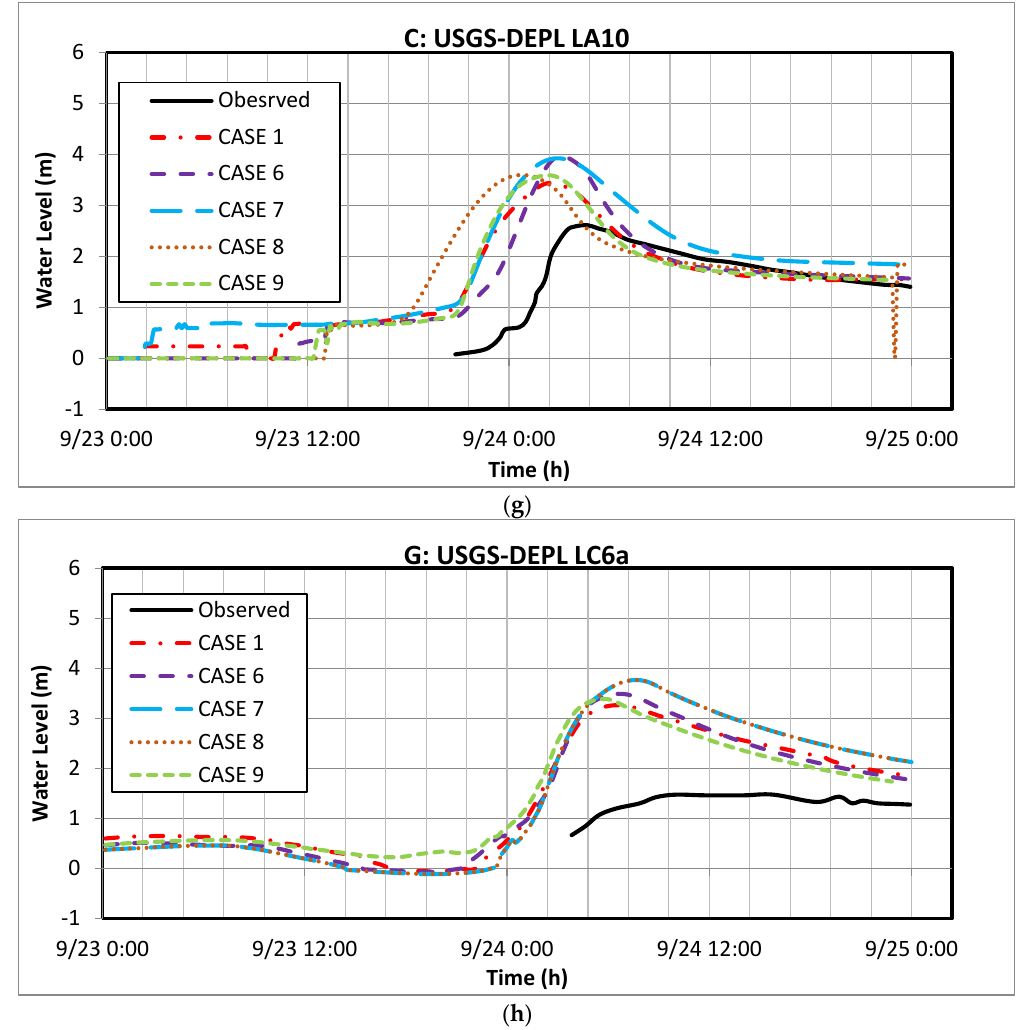
Figure 10. Effect of wind model: Observed and SWAN + ADCIRC modeled significant water level time series at different observation stations during the time of Hurricane Rita (9/23-25/05). ( a ) J—USGS-DEPL LF5; ( b ) H—USGS-DEPL LC8a; ( c ) I—USGS-DEPL LC9; ( d ) D—USGS-DEPL LA12; ( e ) F—USGS-DEPL LC13; ( f ) E—USGS-DEPL LA9; ( g ) C—USGS-DEPL LA10; ( h ) G—USGS-DEPL LC6a.